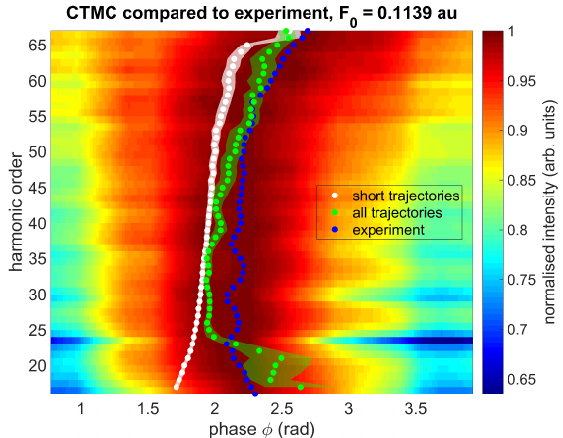
Figure 9. The extracted ϕ max ( n ) curves for the case of only short trajectories (white), and all trajectories with phase matching (green) are compared to the experimental displacement gate plot (colour bar) [18].